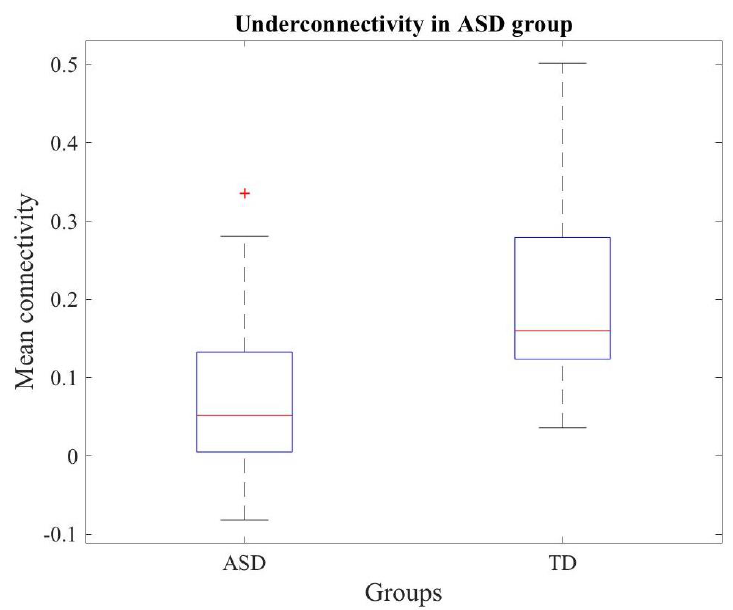
Figure 5. Box and Whiskers diagram representing the mean connectivity in ASD and TD groups for the different connections comprised in the network obtained under the underconnectivity hypothesis.